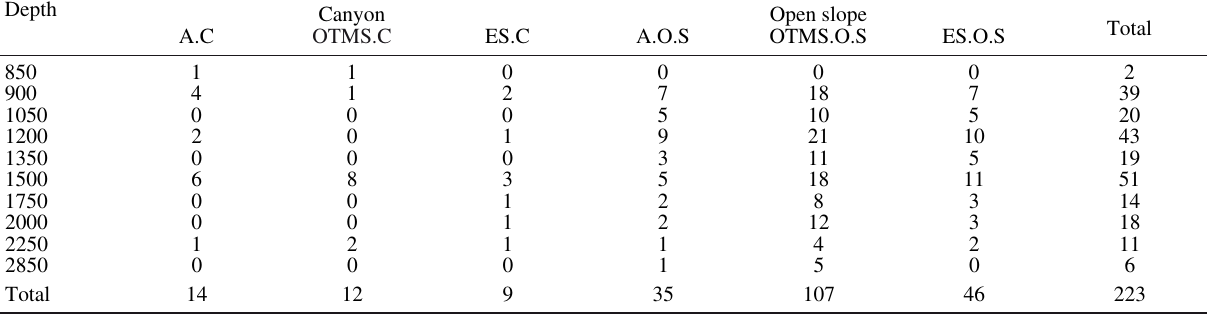
Table 1. – Number of benthic trawls and dredges used in the present study by depth and geomorphological area. Canyon area (including La Fonera, Cap de Creus and Blanes canyons). A.C, Agassizz trawl sampled on Canyon area; OTMS.C, otter-trawl Maireta system sampled on Canyon area; ES.C, epibenthic sledge sampled on Canyon area; A.O.S, Agassizz trawl sampled on open slope; OTMS.O.S, otter-trawl Maireta system sampled on open slope; ES.O.S, epibenthic sledge sampled on open